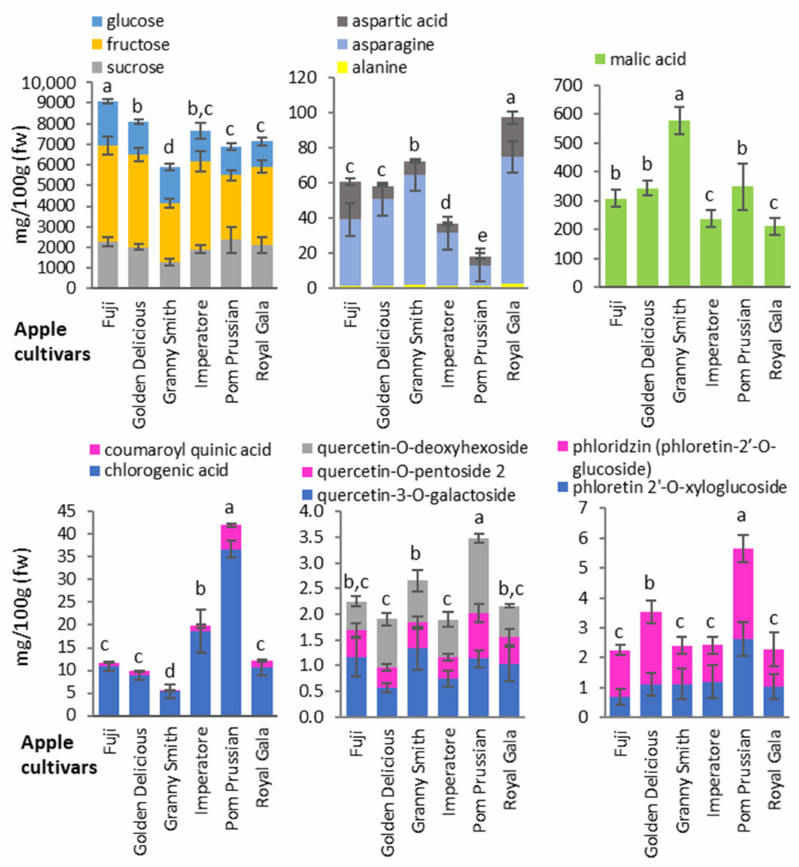
Figure 3. Quantities of the main primary and secondary metabolites in apple cultivars. Primary metabolites were quantified by NMR spectroscopy and secondary metabolites by HPLC-DAD. Data are expressed as mg/100 g fresh weight (fw) and are means of n = 3 samples representing two growing seasons ± standard deviations. Different letters on bars indicate that means referred to the sum of the molecules presented in each graph are significantly different among the apple cultivars according to post-hoc SNK-ANOVA ( p <